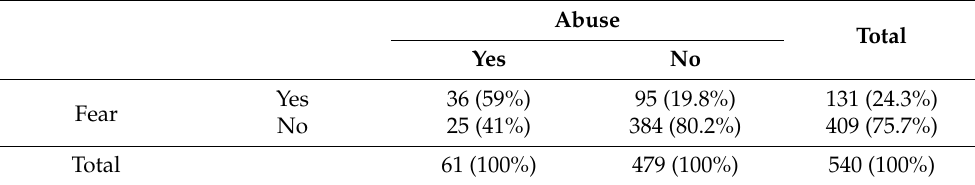
Table 3. Self-perception of abuse in young people of both sexes between 15 and 27 years old.